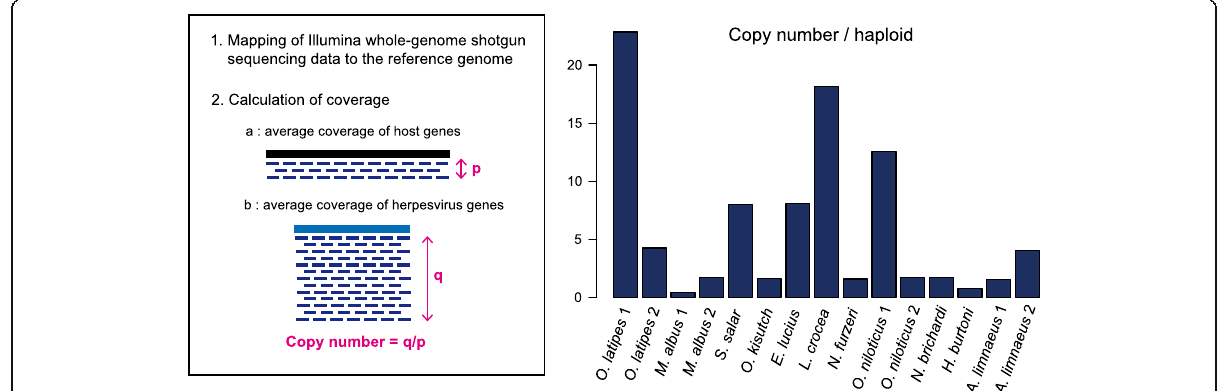
Fig. 3 Teratorn -like viruses exist in multiple copies in host genomes Estimated copy number of Teratorn -like viruses in the genomes of some teleost fishes. Copy number was estimated by mapping of Illumina short read data against reference genome data, calculating the coverage at each nucleotide position, and then dividing the average coverage value of herpesvirus core genes by the average coverage of the coding region of host